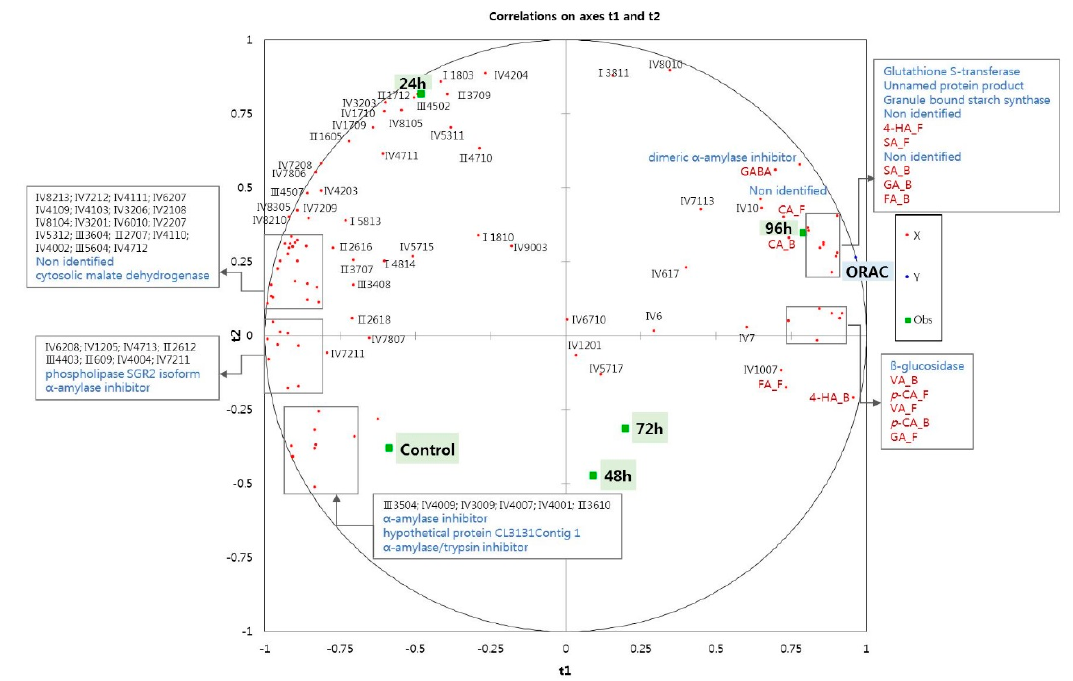
Figure 3. Correlation map of 82 selected protein spots detected on 2DE-gels, phenolic composition, GABA levels (red dot), and ORAC values (blue dot) in ungerminated control and germinated wheat grains after various germination times (24, 48, 72, and 96 h). (CA_F: free caffeic acid; CA_B: bound caffeic acid; FA_F: free ferulic acid; FA_B: bound ferulic acid; SA_F: free syringic acid; SA_B: bound syringic acid; GA_F: free gallic acid; GA_B: bound gallic acid; 4-HA_F: free 4-hydroxybenzoic acid; 4-HA_B: bound hydroxybenzoic acid; VA_F: free vanillic acid; VA_B: bound vanillic acid; p -CA_F: free p -coumaric acid; p -CA_B: bound p -coumaric acid. Regions I, II, III, and IV represent (I) high molecular weight-glutenin subunit, (II) ω -gliadins, (III) α / β and γ gliadins and low molecular weight glutenin subunit; (IV) nonstorage proteins. Numbers refer to the protein spot numbers presented as red circles in Supplementary Figure